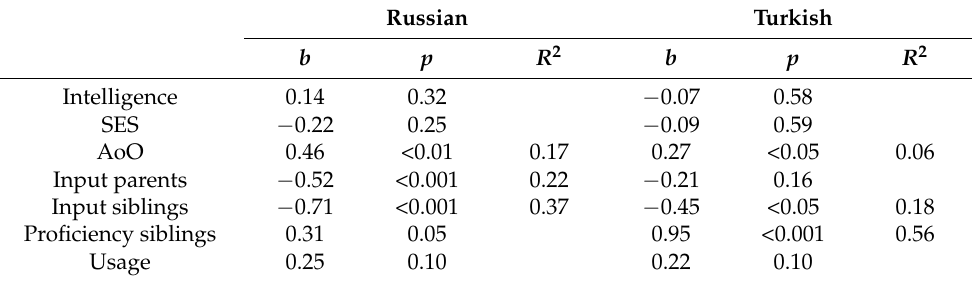
Table 2. Predictors for expressive lexicon at post3 derived from single regression models.